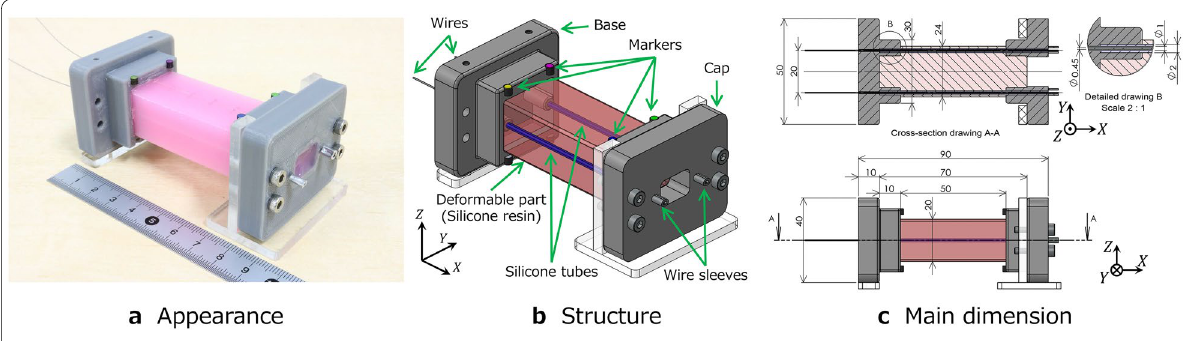
Fig. 2 Prototype of the planar mechanism with two degrees of